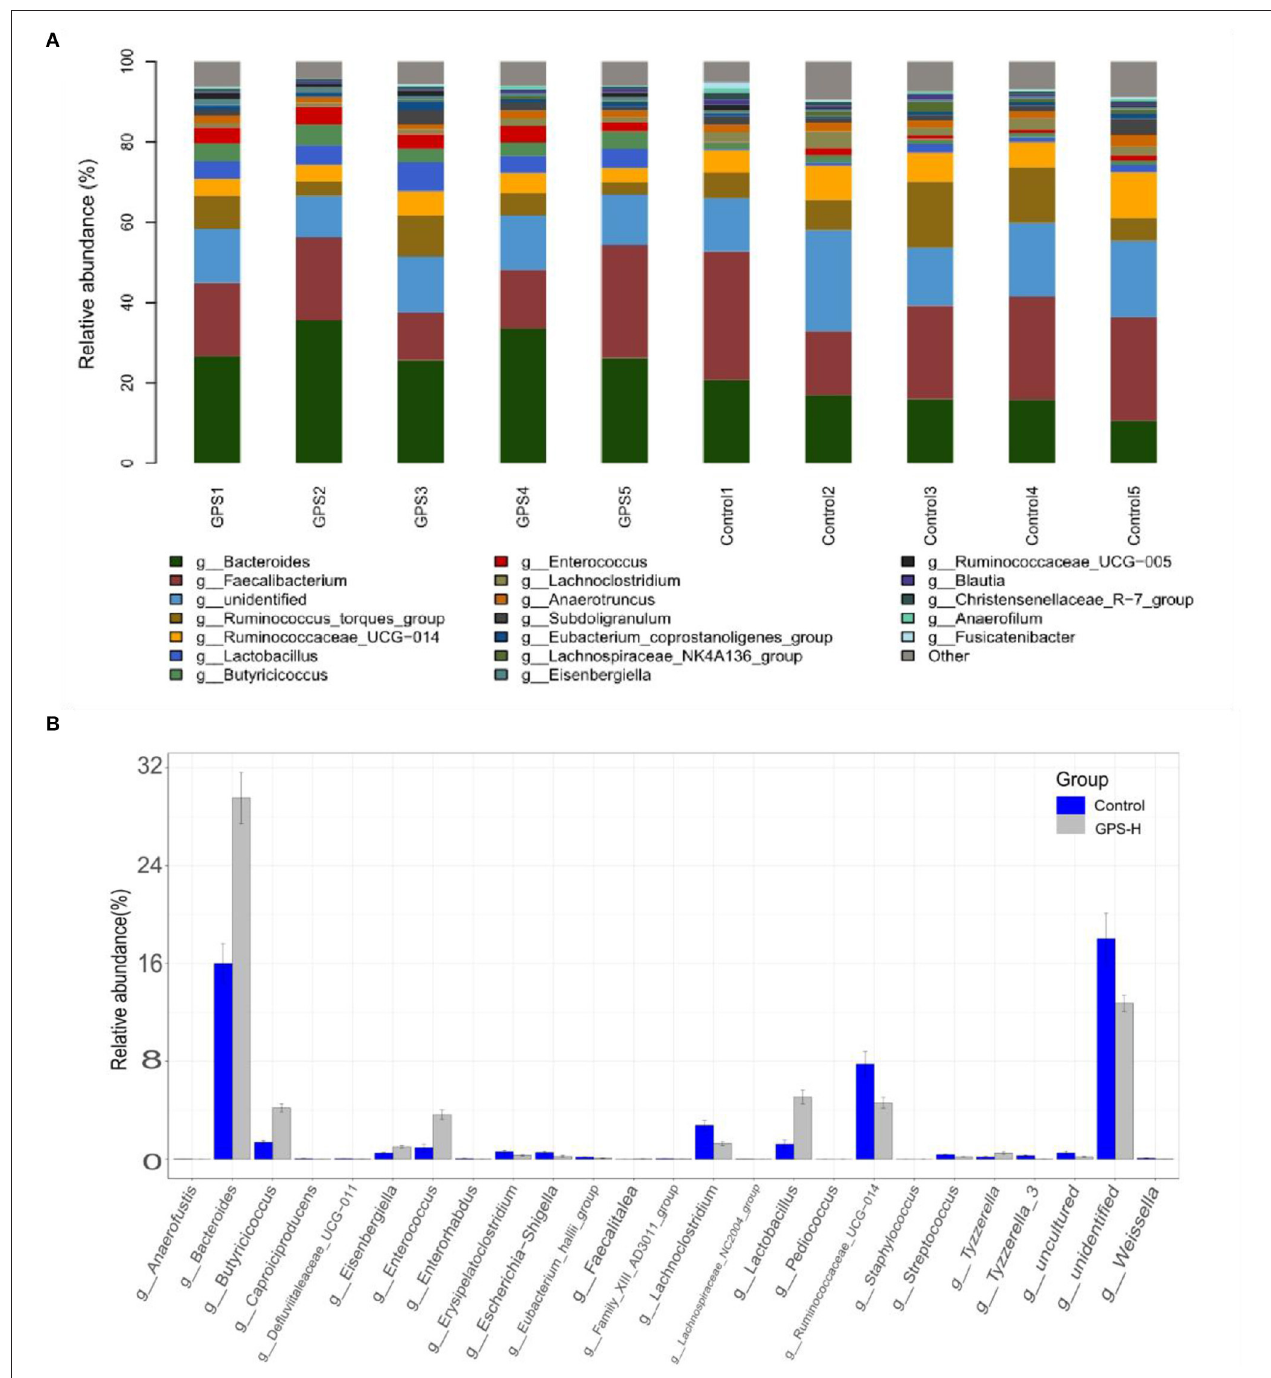
FIGURE 7 | Analysis of significant differences between two groups was analyzed using Metastats analysis, which compares multiple samples under two conditions to find the types of microorganisms that are significantly different in the two groups.The specific composition of intestinal microbiota by genus. (A) The intestinal microbiota structure of each individual in GPS-H and control groups and (B) the average relative abundances of those intestinal microbes.